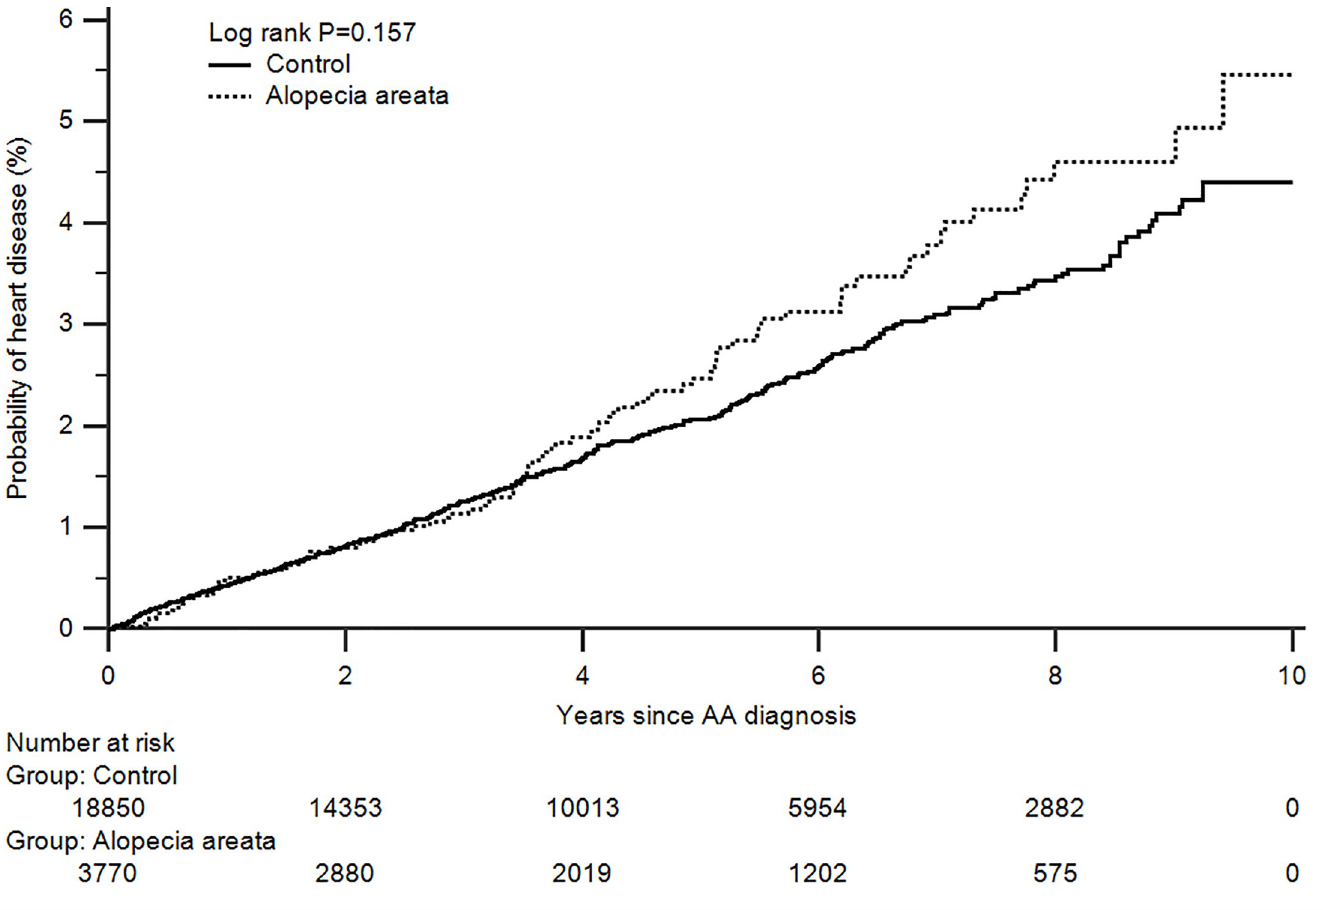
Fig 2. Cumulative incidence of heart diseases in patients with alopecia areata. The difference between the two study cohorts was calculated using the log-rank test.